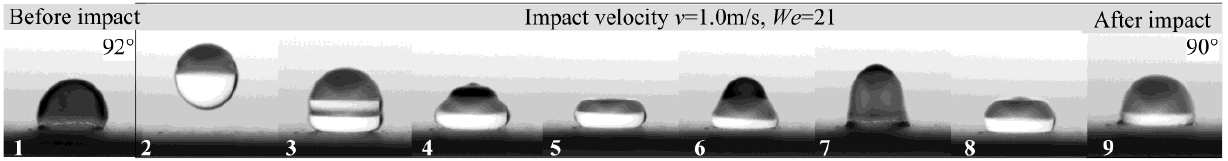
Figure 9. Droplet impact state of the microground BLHS surface.